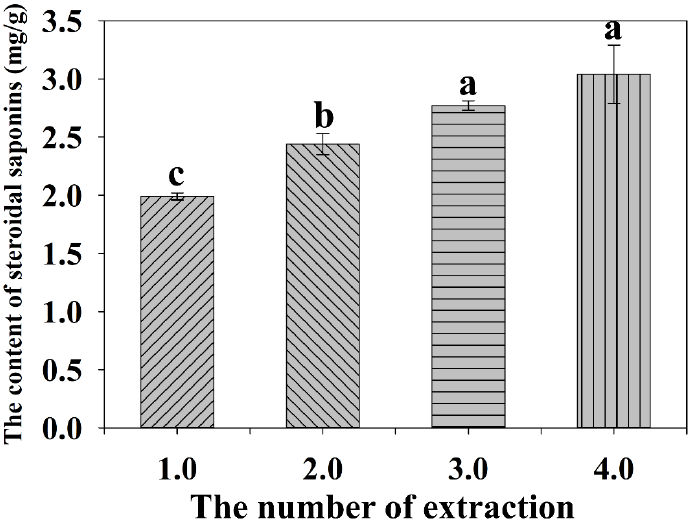
Figure 6. Effect of the number of extractions on the yield of total steroidal saponins. Different lowercase letters represent the difference among treatments of the number of extractions, p ≤ 0.05. Error bars indicate mean values ± SD, ( n = 3).